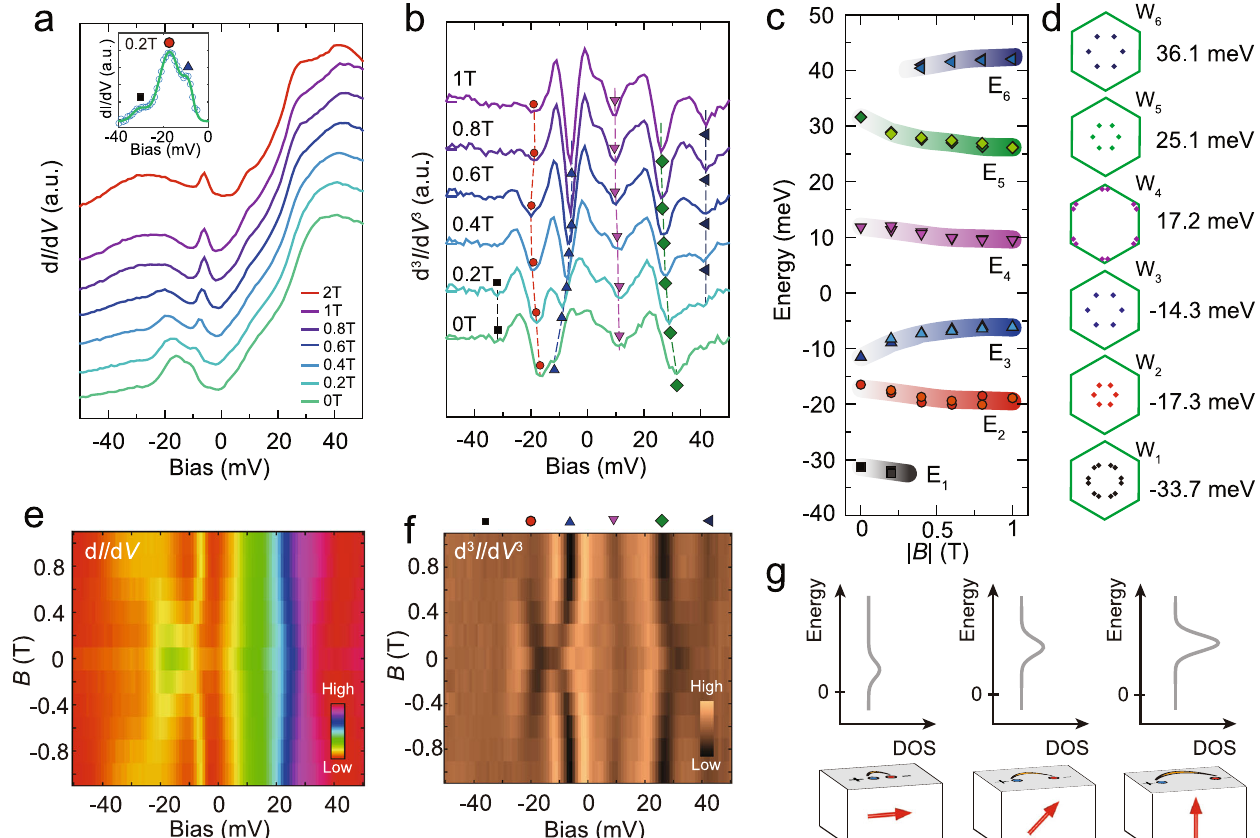
Fig. 3 Magnetization-direction-driven tunability of the prominent spectral features. a Average d I /d V spectra and b second derivative of the spectra (d 3 I /d V 3 ) acquired in a magnetic fi eld applied parallel to the c -axis, offset for clarity. Symbols in ( b ) denote local minima in d 3 I /d V 3 curves, corresponding to the peaks/kinks in the equivalent d I /d V spectra. Dashed lines serve as guides to the eye for the dispersions of local minima in fi eld. Short bars on the left-bottom of each curve in ( b ) indicate the zero value for each curve. c Dispersion of spectral peaks in the magnetic fi eld. The symbols in darker (brighter) colors are extracted from the data taken in positive (negative) fi elds. d Theoretically calculated Weyl node positions for magnetization saturated along the c -axis 27 . Waterfall plots of ( e ) d I /d V and f d 3 I /d V 3 as a function of the magnetic fi eld applied parallel to the c -axis, including the data acquired in negative fi elds (antiparallel to the c -axis), presented as intensity maps in different color scales for a better visualization. g Schematic of one scenario of Weyl node evolution and its effect on the density of